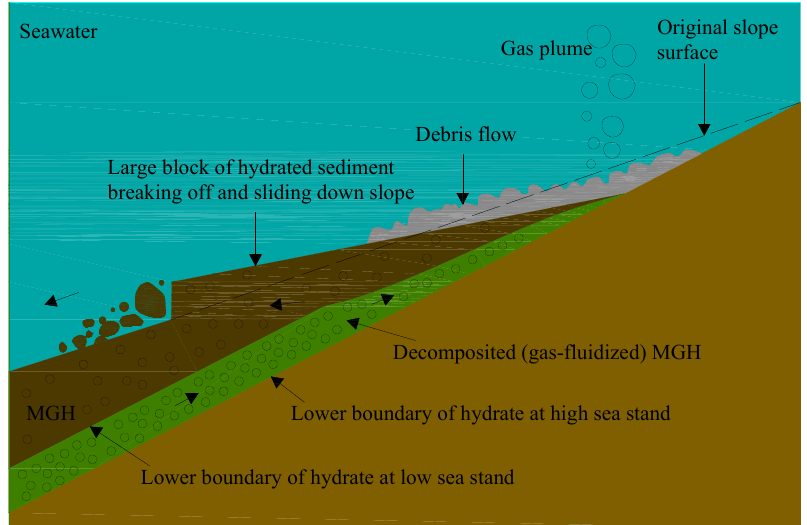
Figure 4. Schematic depiction of the mechanism that causes submarine landslides [23].